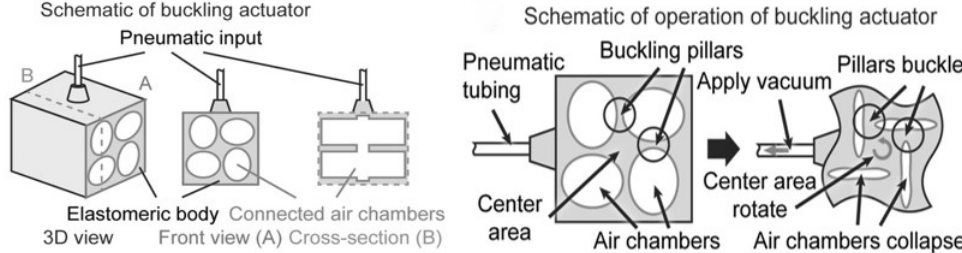
Figure 3. A Vacuum-powered buckling actuator [76] , reproduced with permission from [76] , 2015, John Wiley and Sons.